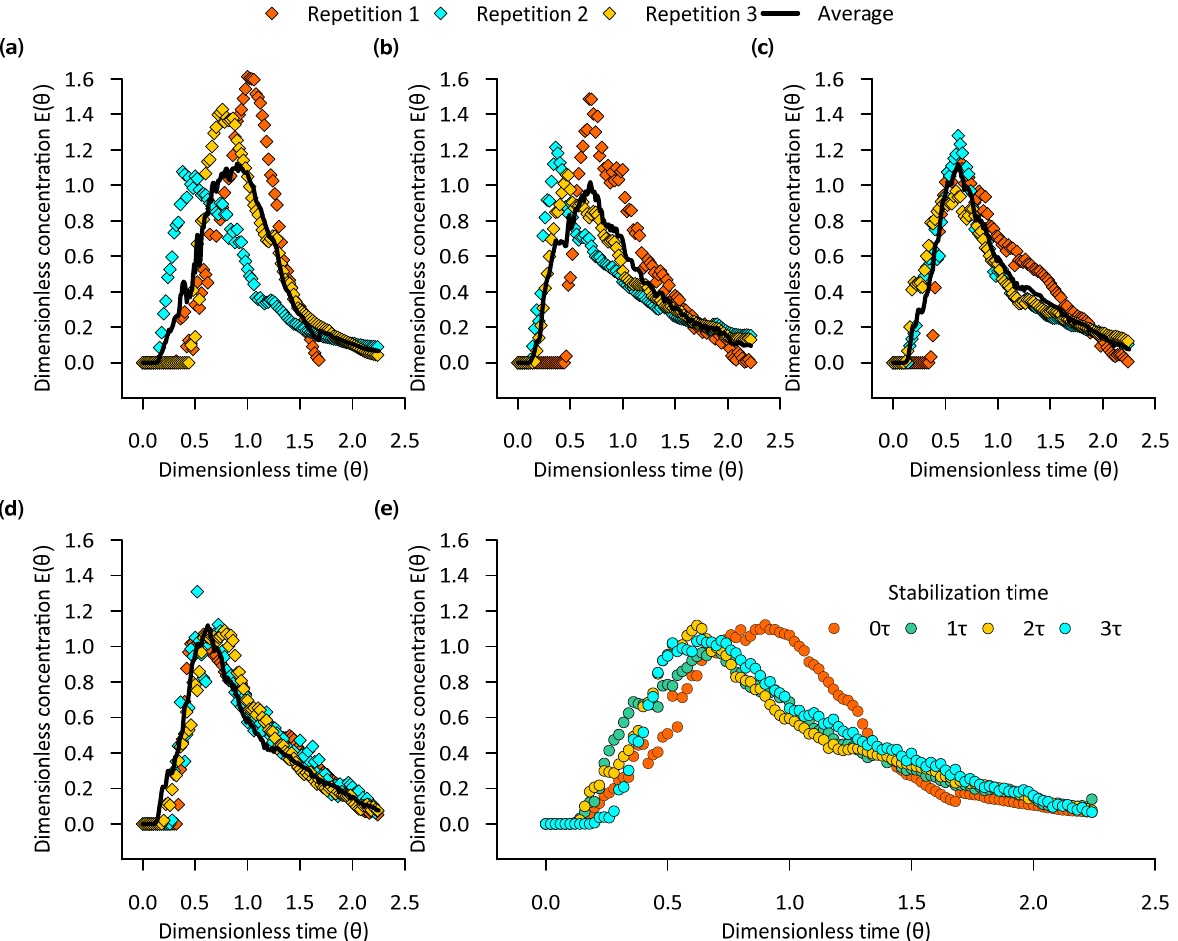
Figure 4. Effect of time stabilization on RTD characterization: ( a ) 0𝜏 stabilization time, ( b ) 1𝜏 stabilization time, ( c ) 2𝜏 stabilization time, ( d ) 3𝜏 stabilization time, ( e ) Comparison of averaged results.